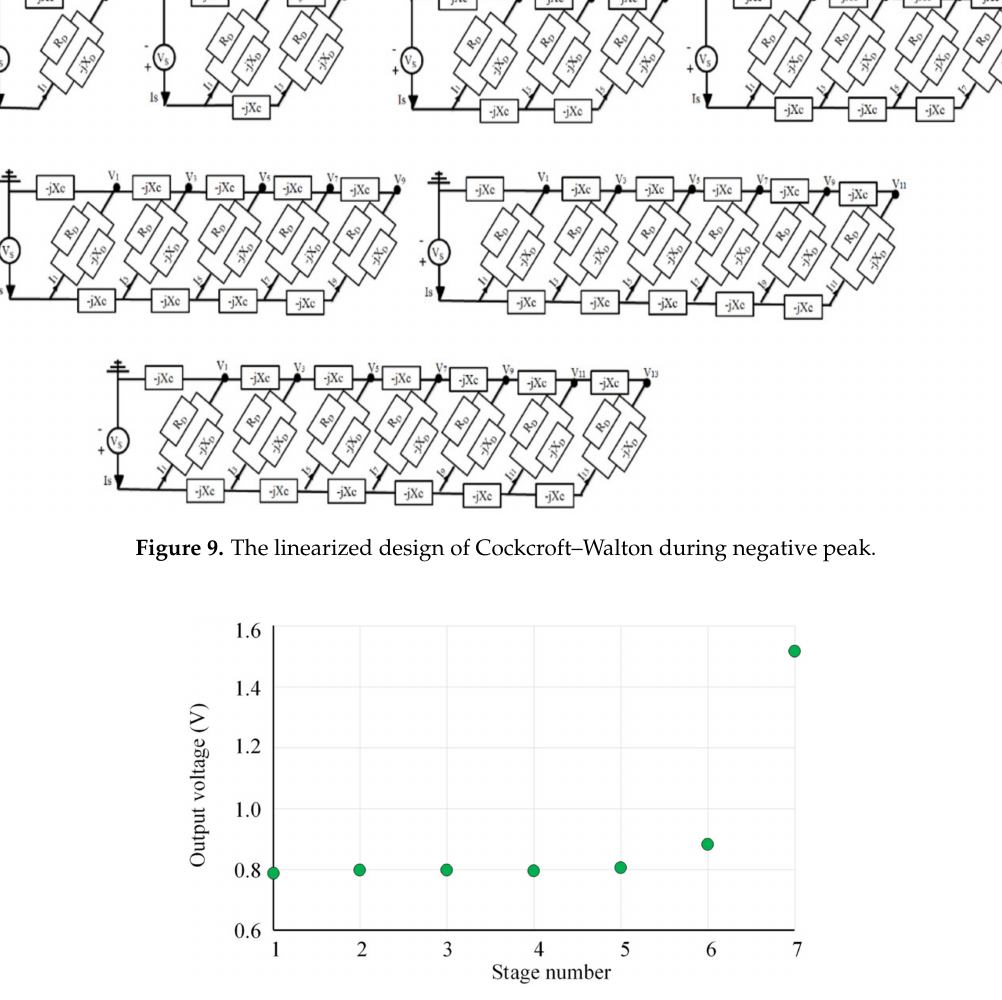
Figure 10. Verification result for the mathematical expression of Cockcroft–Walton voltage multiplier using